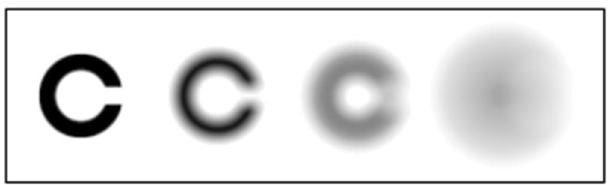
Figure 2. Landolt Rings rendered with 0, 1, 2 and 4 D of equivalent defocus. The angular size of Landolt Ring was